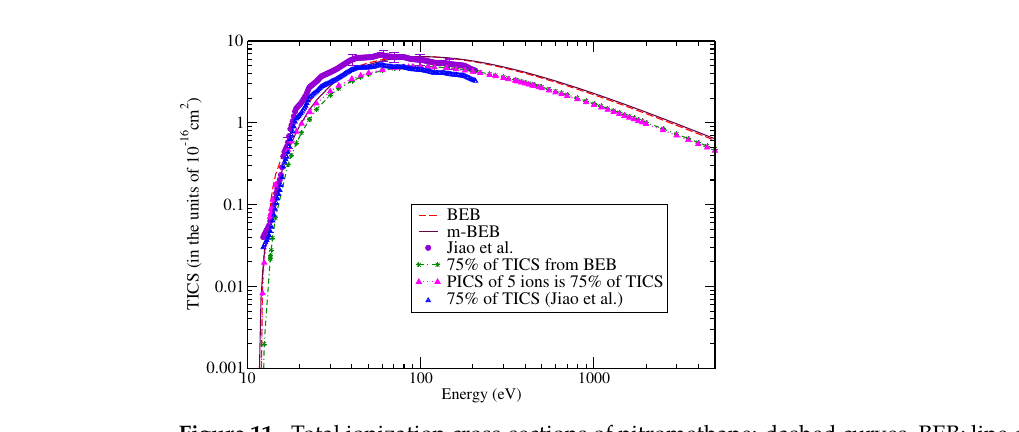
Figure 11. Total ionization cross-sections of nitromethane: dashed curves, BEB; line curves, m-BEB; circles, Jiao et al.